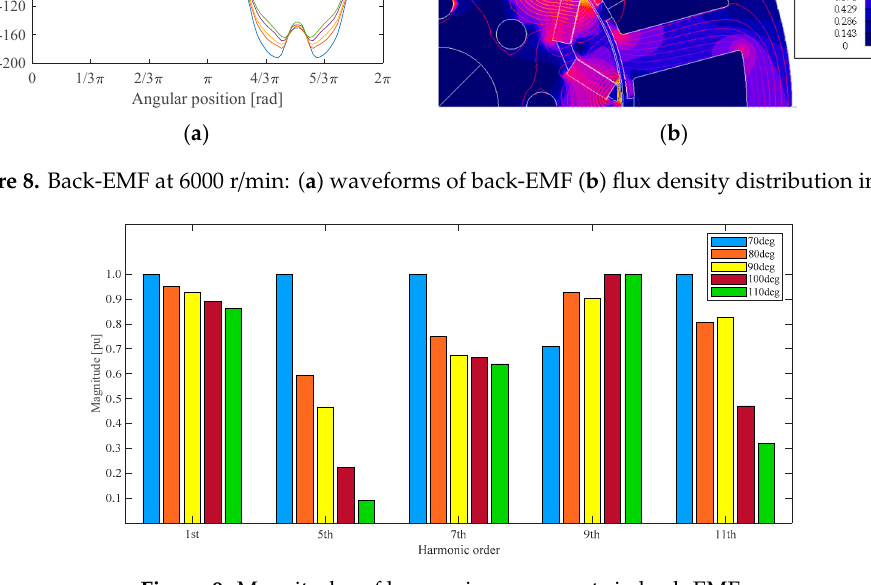
Figure 9. Magnitudes of harmonic components in back-EMF. Table 2. PM flux linkage and THD in back-emf.